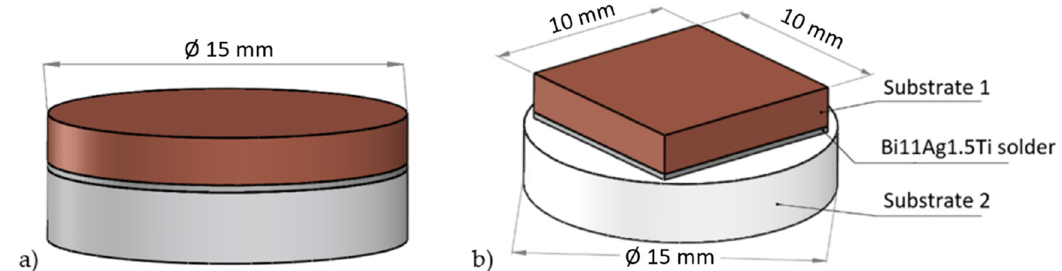
Figure 2. Assembly of soldered joint: ( a ) for analysis of solder/substrate joint; ( b ) for shear strength measurement.